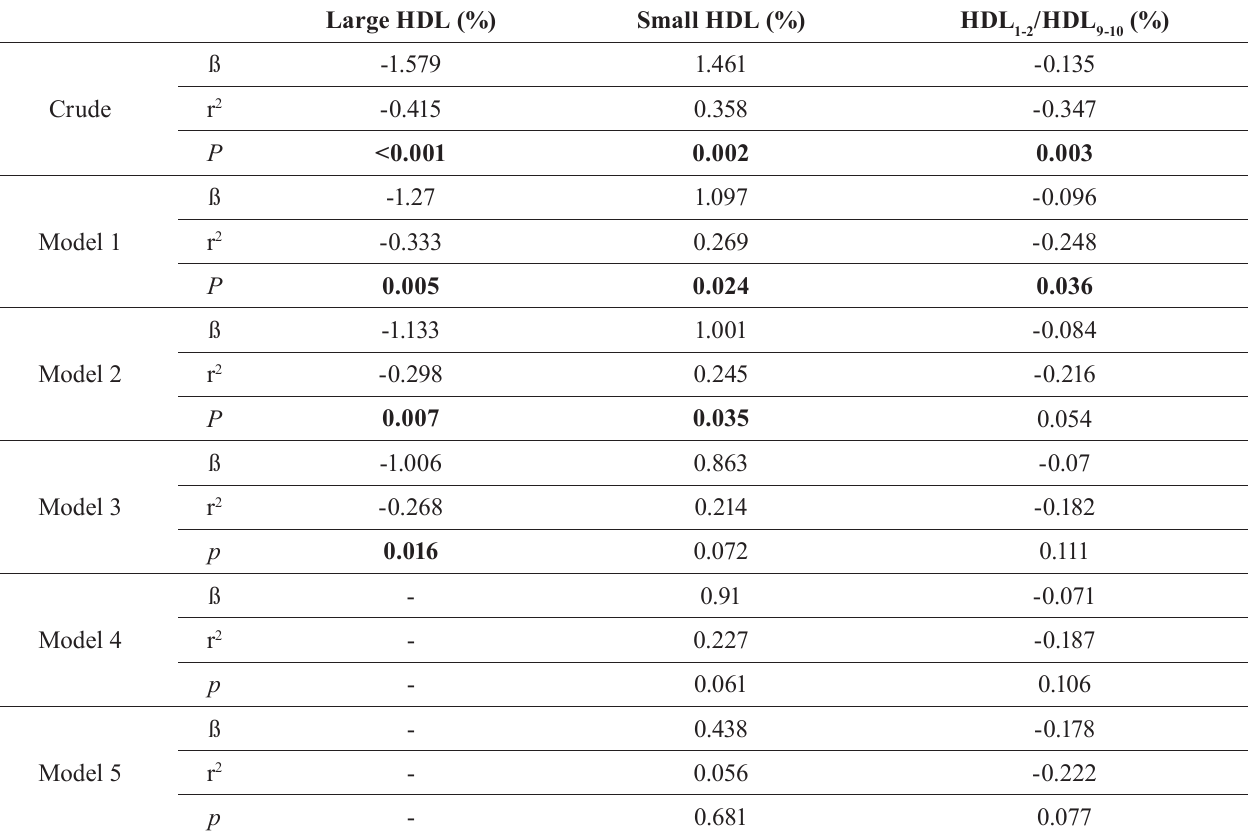
TABLE VI - Influence of triglycerides concentration (per each 50 mg/dL) on the percentage of large and small HDL,